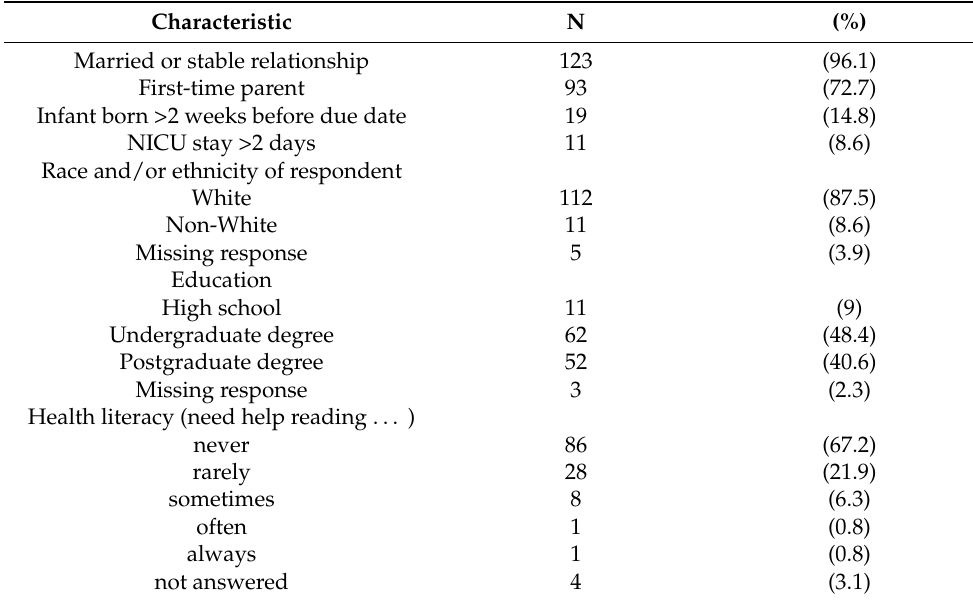
Table 2. Sample Characteristics for 128